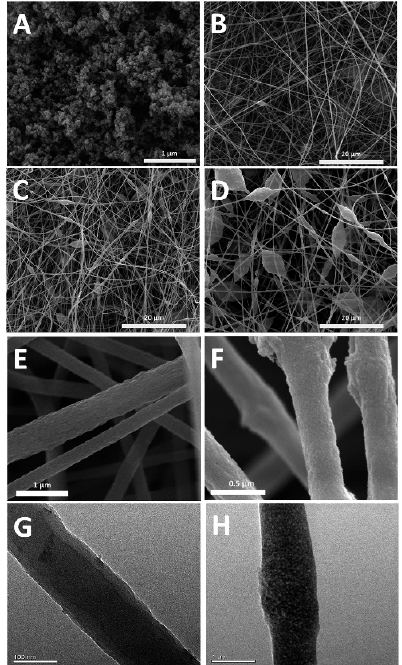
Figure 4. SEM images of SNW-1 ( A ), SNW-1@PAN 0.05 ( B and F ), SNW-1@PAN 0.1 ( C ), SNW-1@PAN 0.2 ( D ) and PAN nanofiber ( E ); TEM images of PAN ( G ) and SNW-1@PAN 0.05 ( H ). Reprinted from [42] with permission of Elsevier.